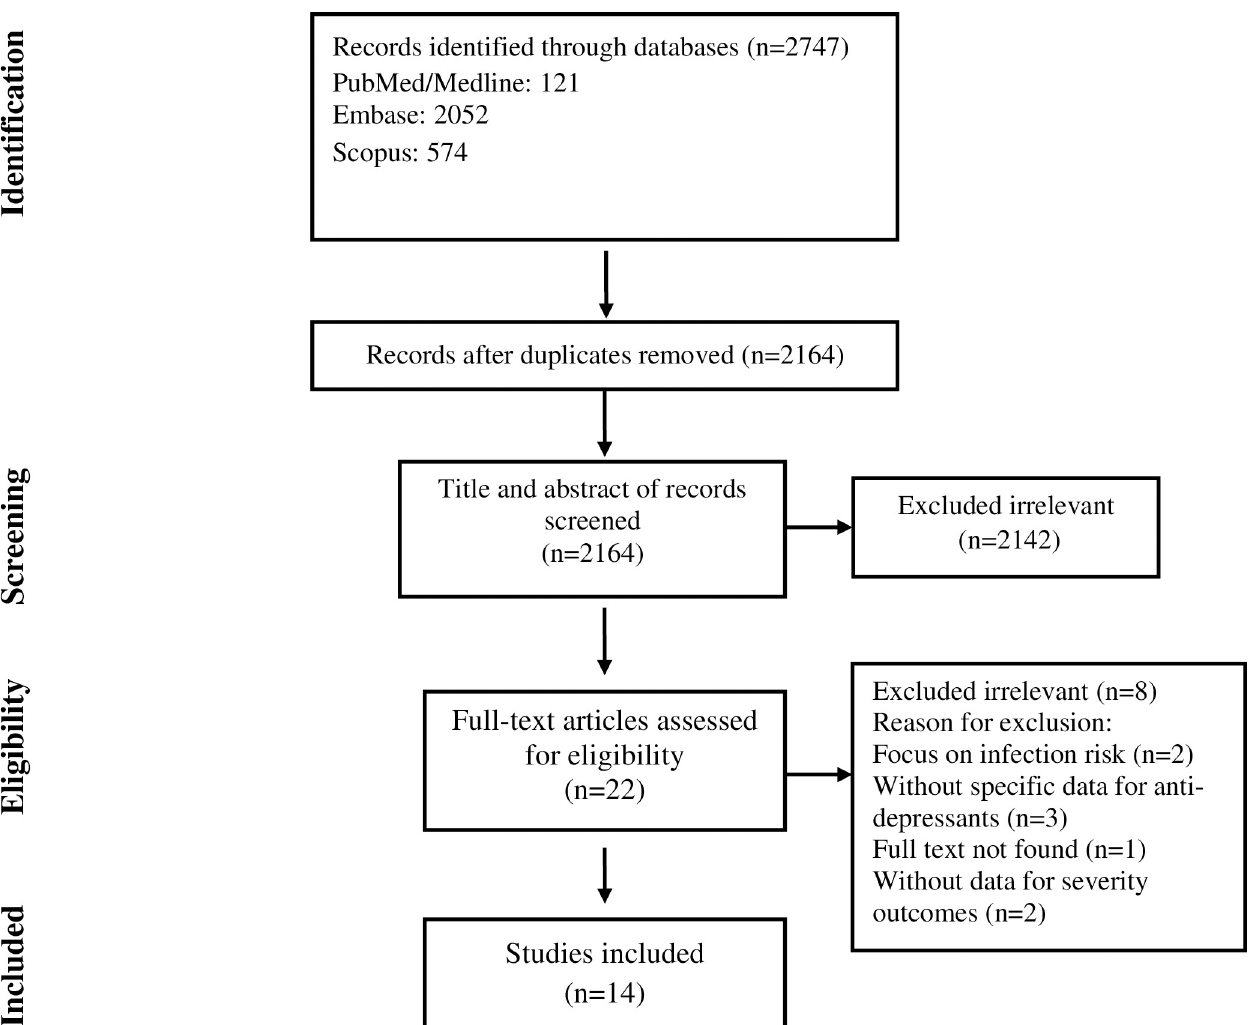
Fig 1. Flow chart of study selection for inclusion in the systematic review and